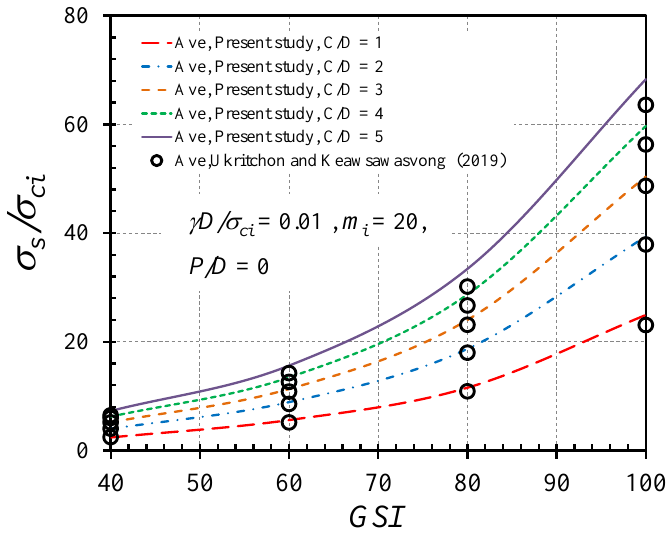
Figure 9. Comparison between the results of ANN and past work by [43].